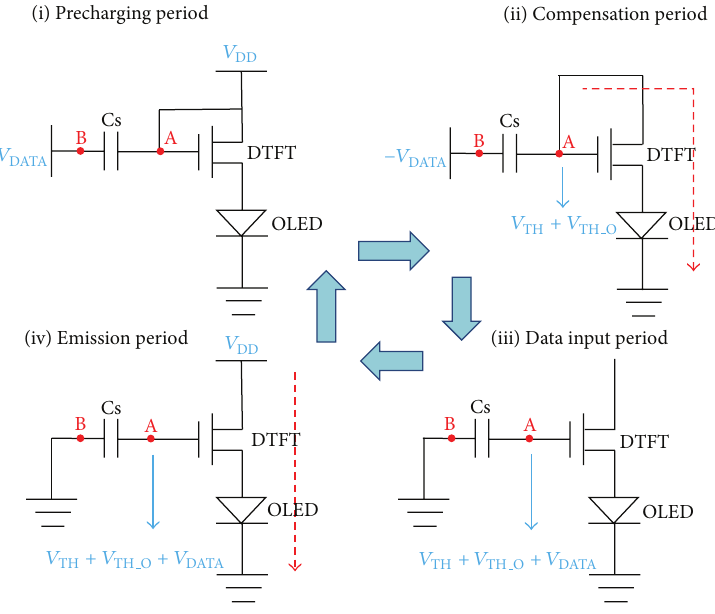
Figure 3: Equivalent circuit at each state in operation.